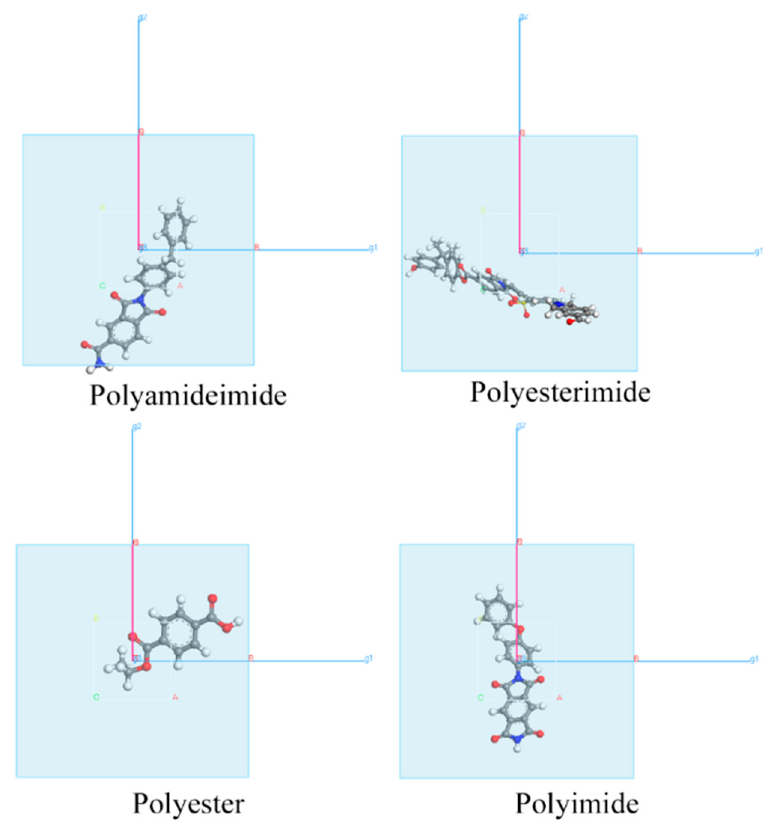
Figure 5. Brillouin zones for PAI, PET, PEI and PI. The ordinate of the energy band diagram is the energy, and when the energy is 0 eV, it represents the Fermi level. Energy below 0 eV represents the valence band, and energy above 0 eV represents the conduction band. The band gap is between the valence band’s highest energy position and the conduction band’s lowest energy position. Mate- rial has a direct band gap when the valence band’s tallest and the conduction band’s lowest energy are in the same position. Material has an indirect band gap when the va- lence band’s highest energy and the conduction band’s lowest energy are not in the same position. Figure 6 is band gap and density of states of PAI, PET, PEI and PI. Figure 6a,c,e,g are the energy band diagrams of four molecules of PAI, PET, PEI and PI; Figure 6b,d,f,h are comparison charts of PDOS and DOS. The figures show the total density of states of each molecule and the partial density of states of the four main constituent ele- ments of the molecule: nitrogen, oxygen, carbon, and sulfur.